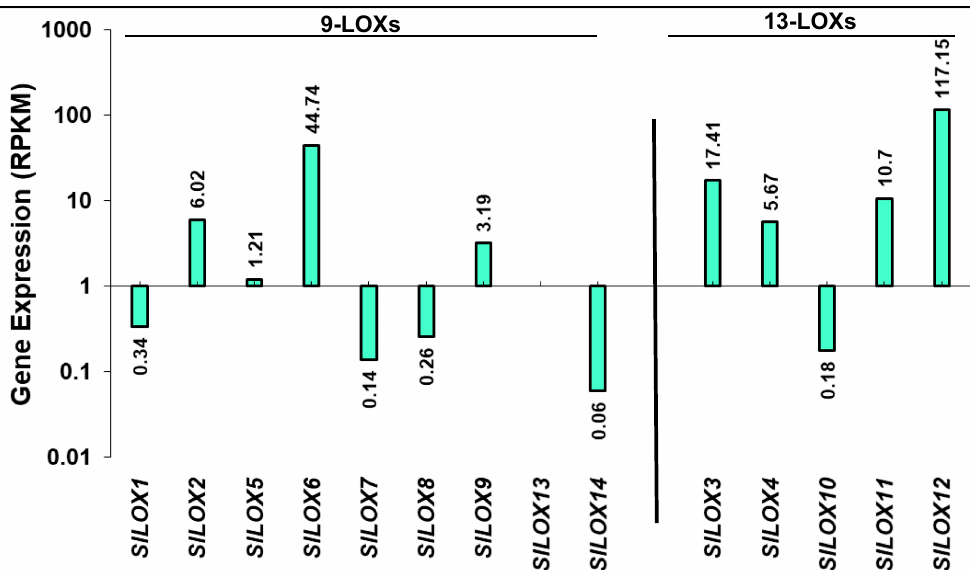
Figure 2 . Relative transcript abundance of 9-LOX and 13-LOX gene family members in the leaf tissue of S. lycopersicum cv. Heinz tomato. The bars represent processed reads per kilobase of transcripts per million mapped reads (RPKM) for the tomato leaf LOX genes derived from RNA-seq data (International Tomato Genome Sequencing Consortium [SGN] database) as described in the Materials and Methods section [26]. Y-axis as Log2 scale with inverted axis shows gene members minimally active in the leaf.